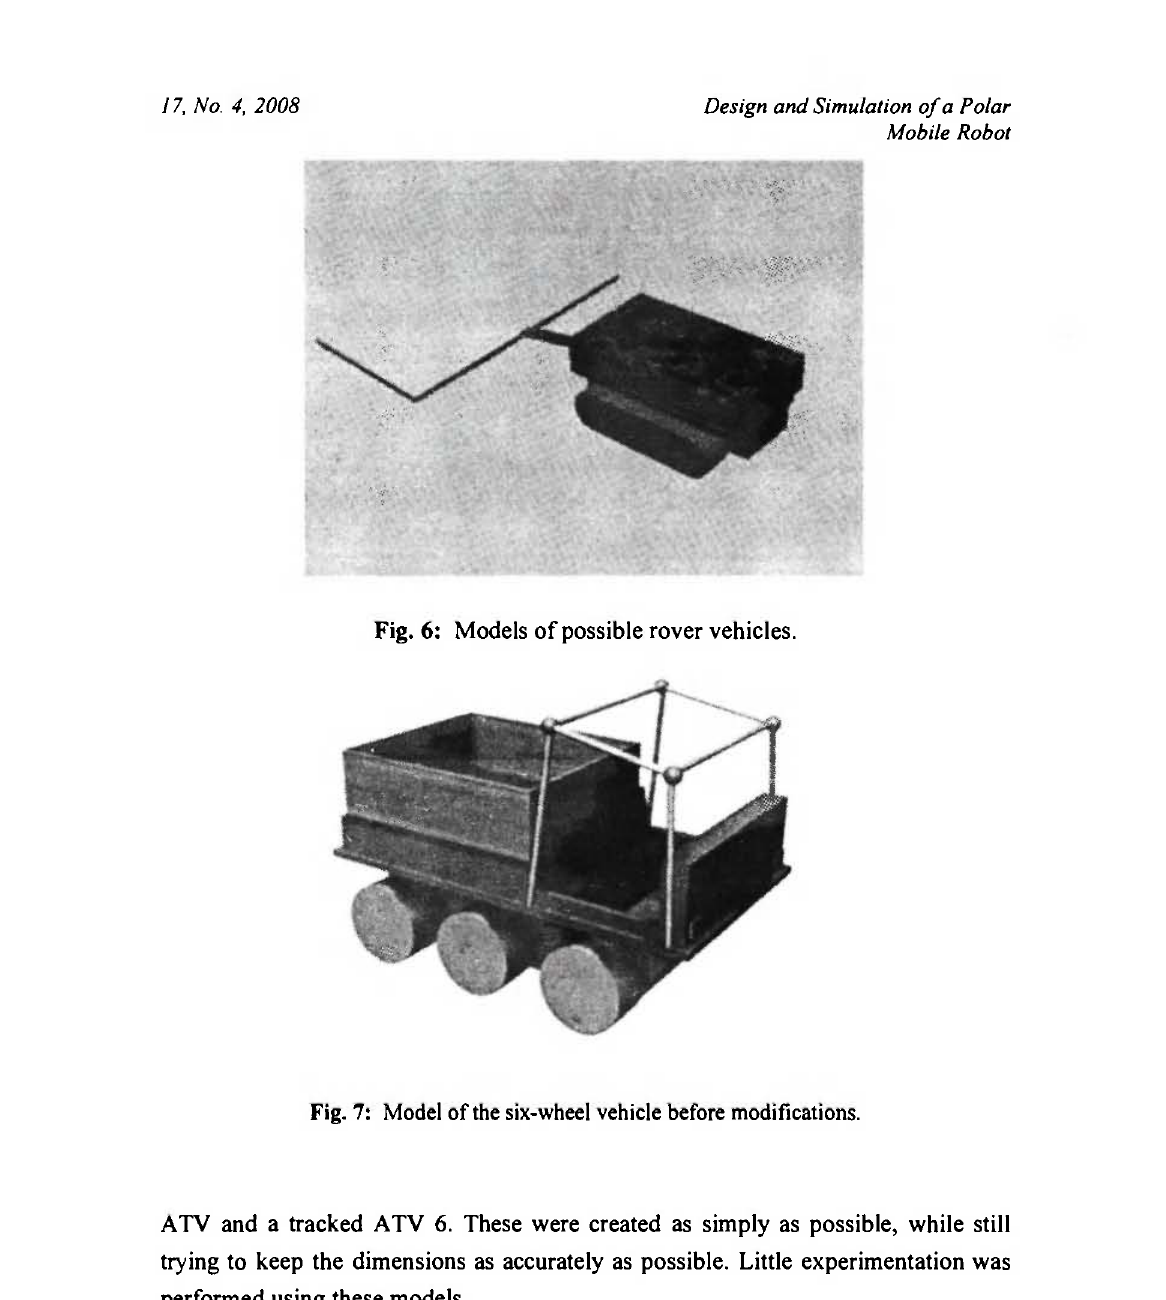
Fig. 7: Model of the six-wheel vehicle before